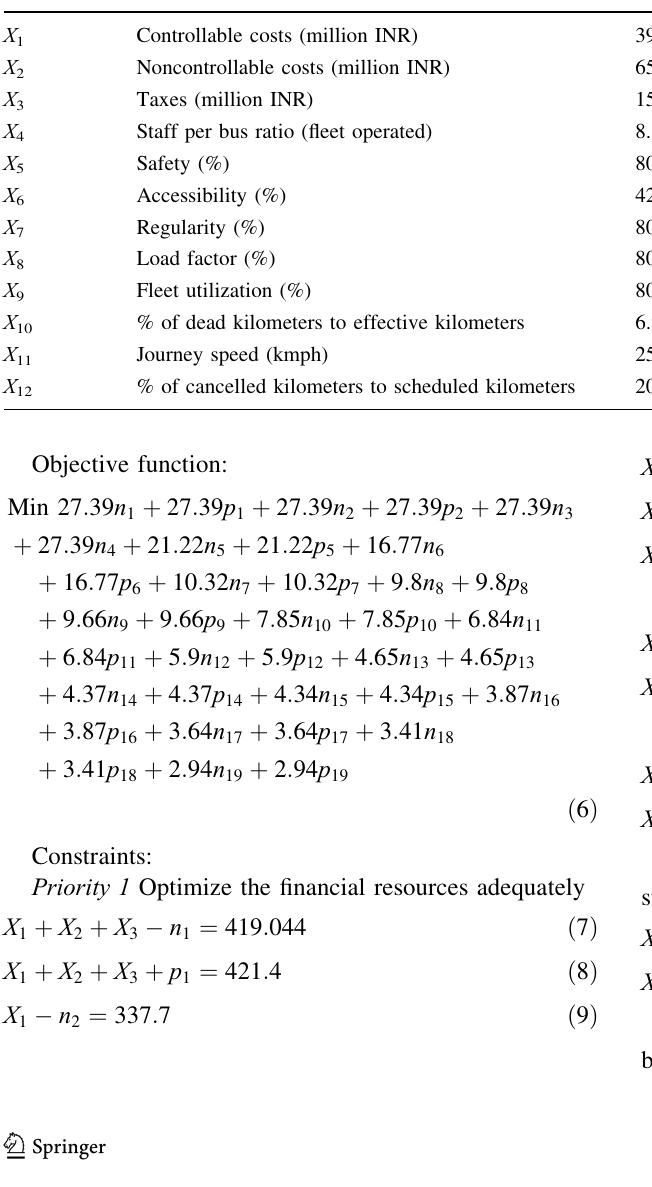
Table 8 Optimal and actual values for decision variables